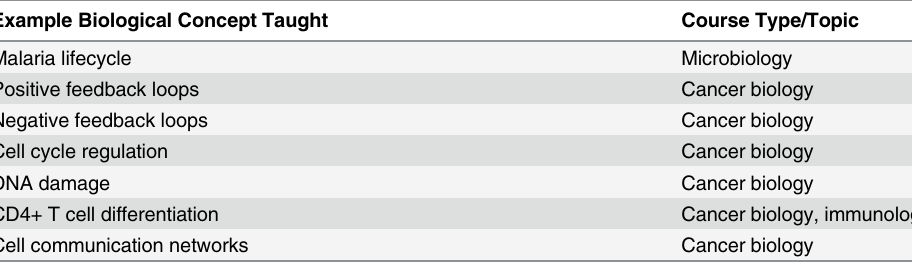
Table 1. List of developed modeling